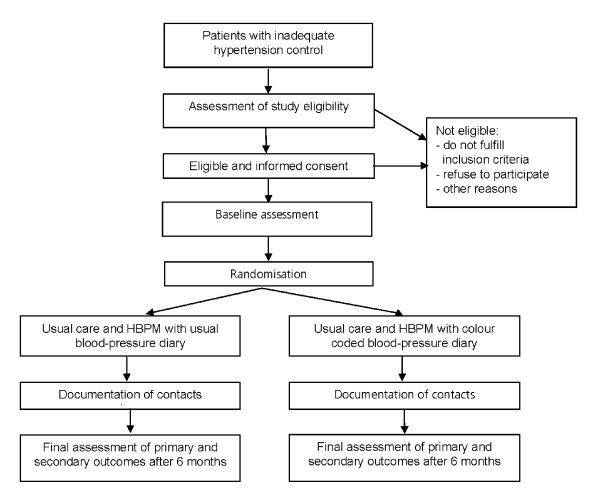
Study flow chart.